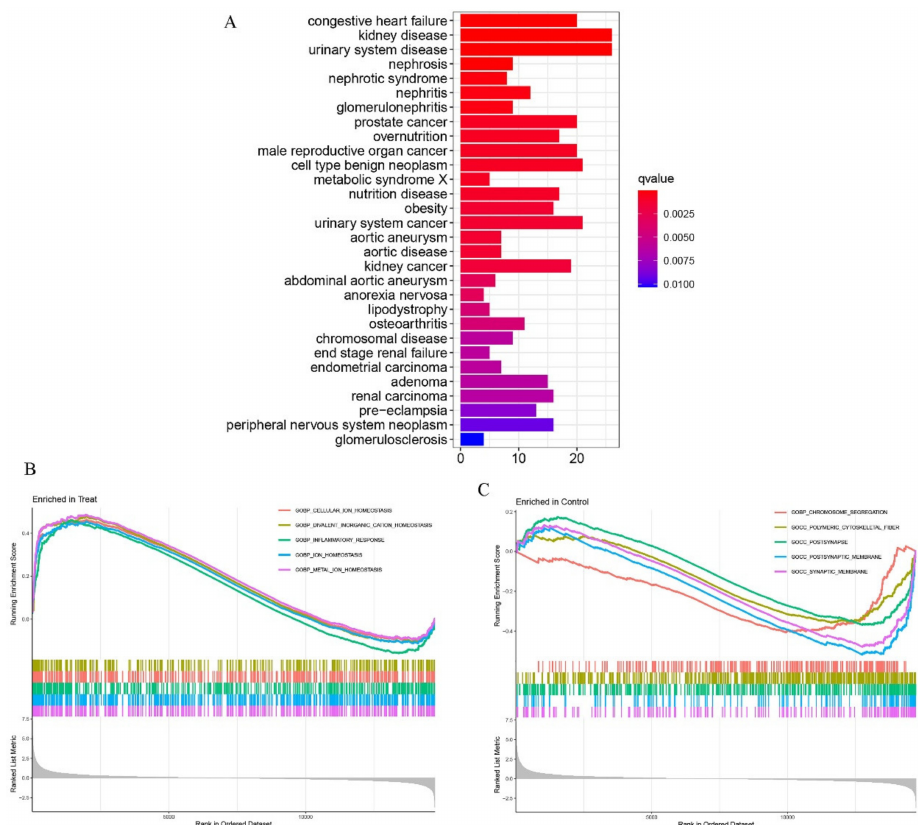
Figure 4. ( A ) Disease ontology (DO) analyses were conducted to predict the potential related diseases of the differentially expressing genes between the treat and the control group. ( B , C ) GSEA showed that the top 5 signal pathways were most related to treat ( B ) and control group ( C